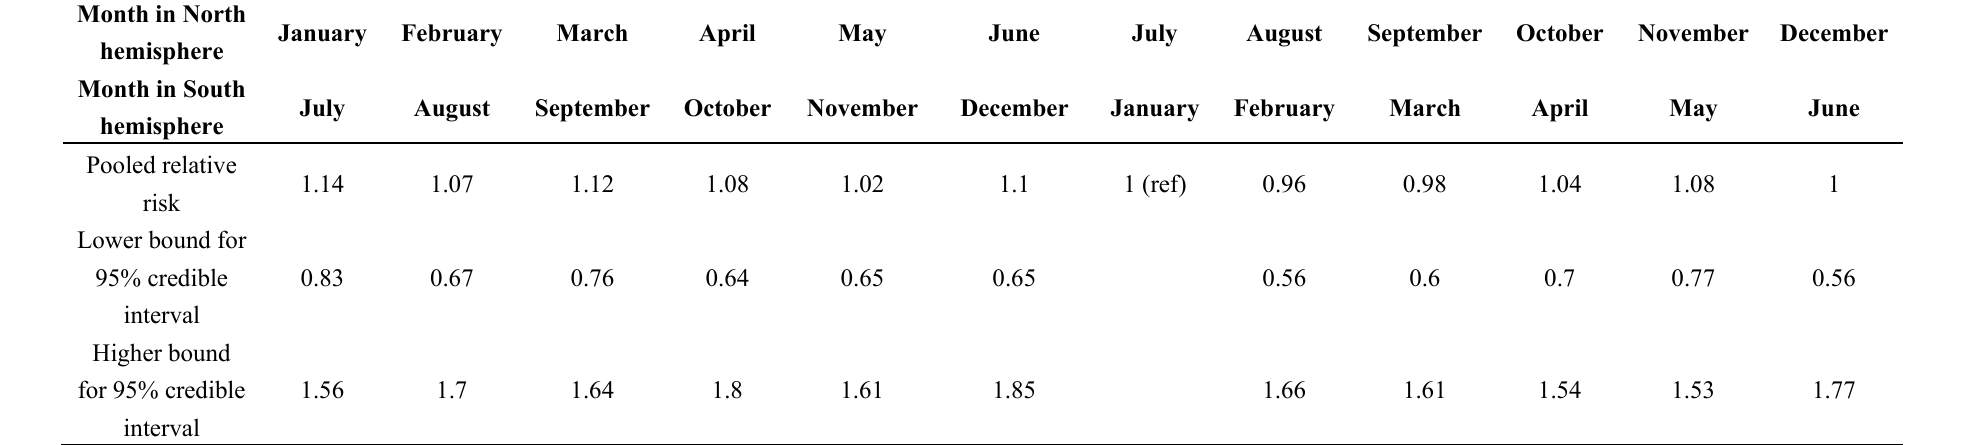
Table A4. Pooled relative risks and 95% credible interval for the association between month of birth on preeclampsia incidence after excluding [21]. Month in North hemisphere Month in South hemisphere Pooled relative